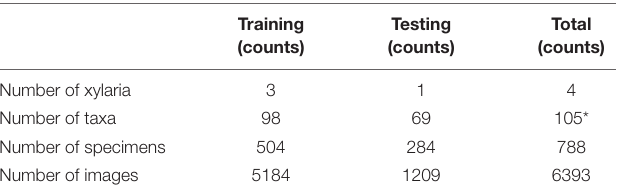
TABLE 2 | Image data set